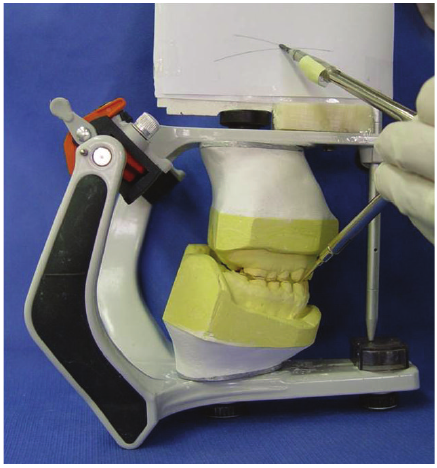
Figure 3: Occlusal plan evaluation using the Broadrick occlusal plane